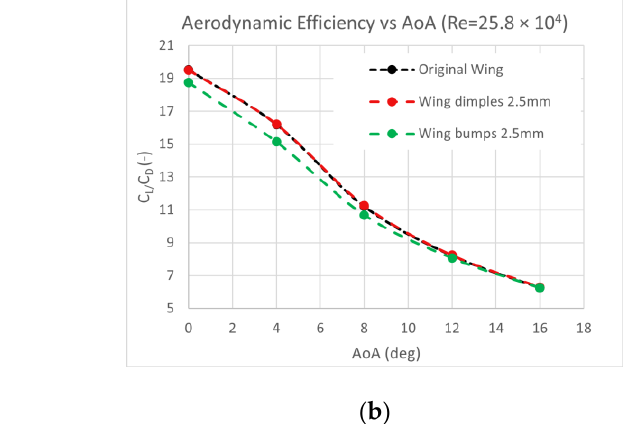
Figure 11. Lift-to-Drag ratio of the three wings under ( a ) Re = 86,000 and ( b ) Re = 258,000.